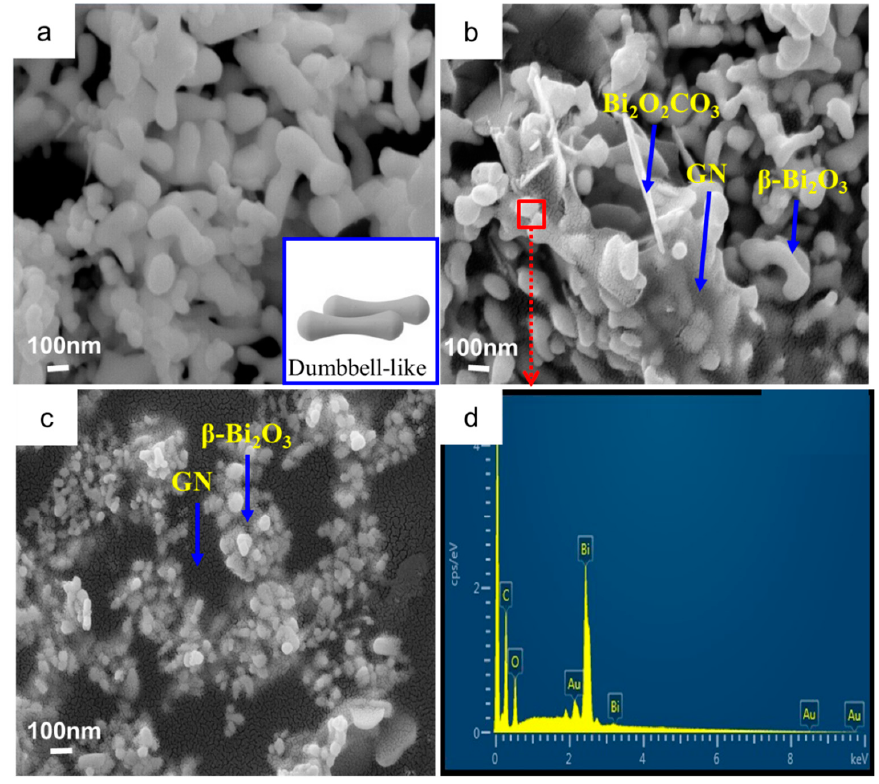
Figure 3. ( a ) SEM images of pure β -Bi 2 O 3 ; ( b , c ) β -Bi 2 O 3 /GN(1%); and ( d ) EDS pattern of β -Bi 2 O 3 /GN.